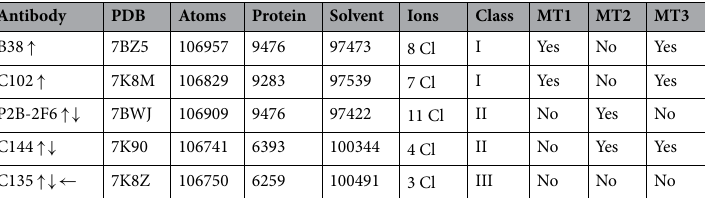
Table 1. Details of the simulations used in this work, including the antibody name and PDB file used in the simulations. Total number of atoms in the simulation includes the proteins, and solvent used in the different − simulations. Number of Cl ions used to balance the charge in the simulations. The Class of the antibodies is also specified. The symbols indicate whether the antibody links to the RBD in the up ( ↑ ), up/down ( ↑↓ ), or up/ down from the side ( ↑↓← ). The last three columns indicate if the antibody was modeled with mutations